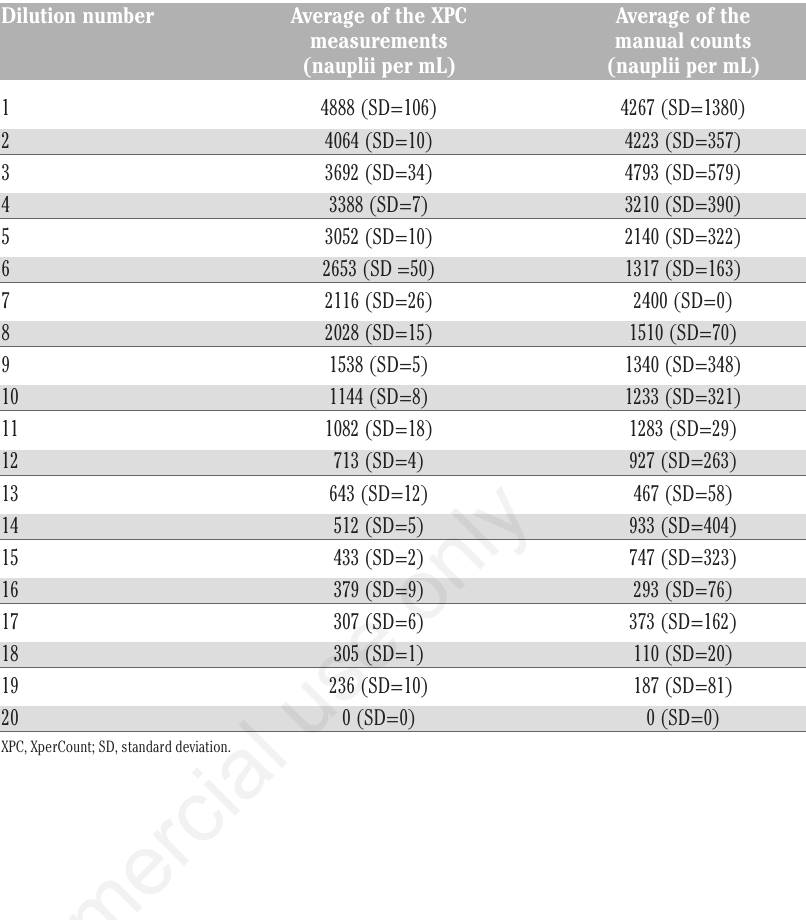
Table 1. Results for Artemia nauplii counting methods.